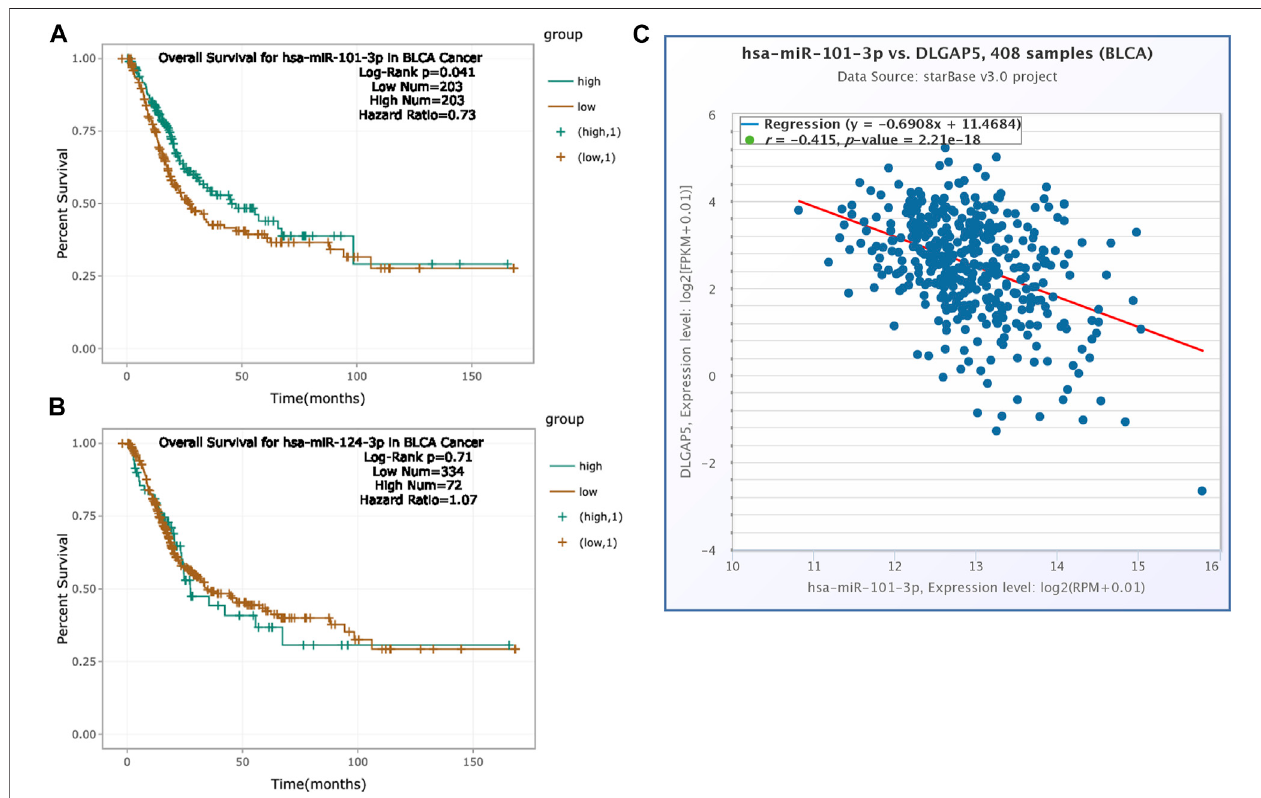
FIGURE 7 | Prognosis analysis of hsa-mir-124-3p and hsa-mir-101-3p. (A) The K-M survival curve of hsa-miR-101-3p. High expression of hsa-miR-101-3p had positive overall survival for bladder cancer patients (Log-Rank p = 0.041, Hazard Ratio = 0.73). Green curve represented high expression of hsa-mir-101-3p and brown curve represented low expression of hsa-mir-101-3p. (B) The K-M survival curve of hsa-mir-124-3p. The result was no statistical signi fi cance (Log-Rank p = 0.71, HazardRatio= 1.07). (C) Theco-expressionbetween hsa-mir-101-3pwithDLGAP5 in bladdercancerpatients. Theresult showsthathsa-mir-101-3p expression level had negative relation with DLGAP5 expression level (r = − 0.415).The p value was